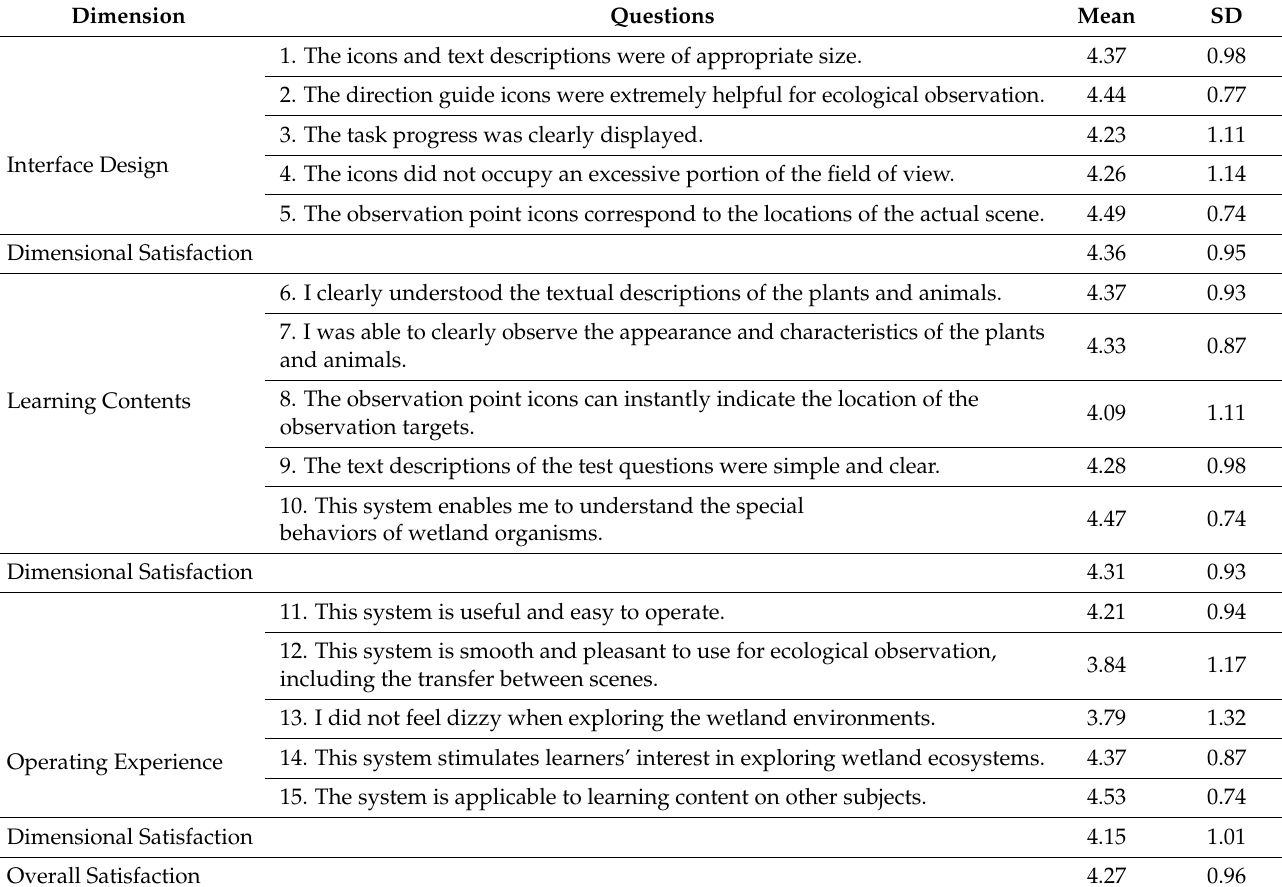
Table 9. Questionnaire results of user satisfaction for the experimental